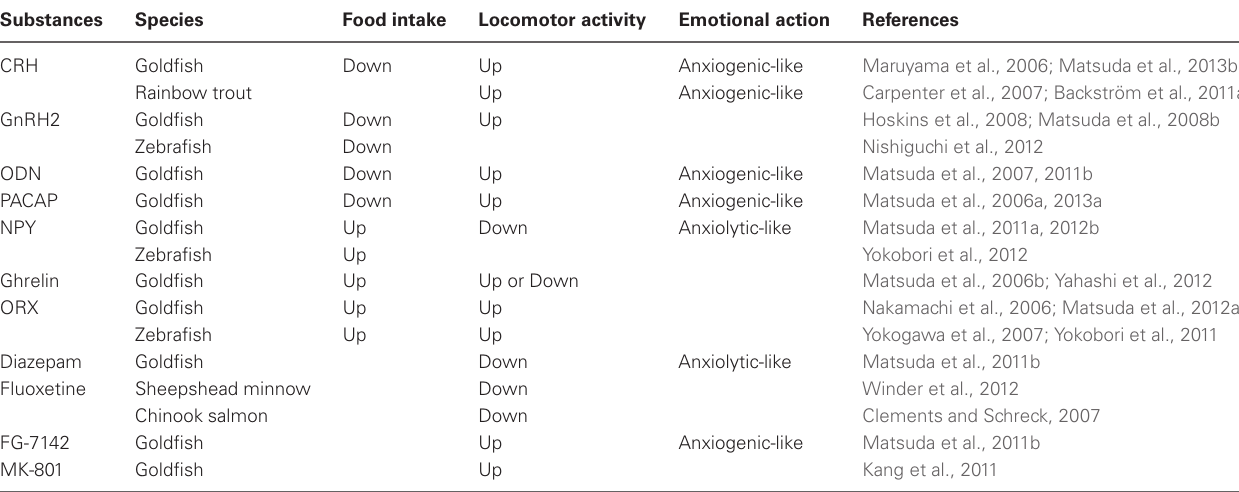
Table 1 | Effects of neuropeptides and psychophysiological compounds on food intake, locomotor activity, and emotional action in